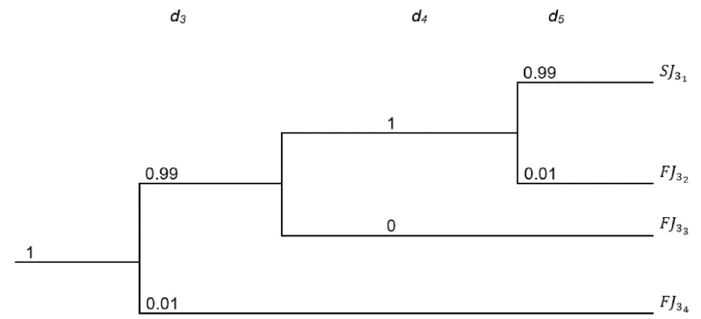
Figure 11. Event tree for activity d 3, d 4, d 5 .